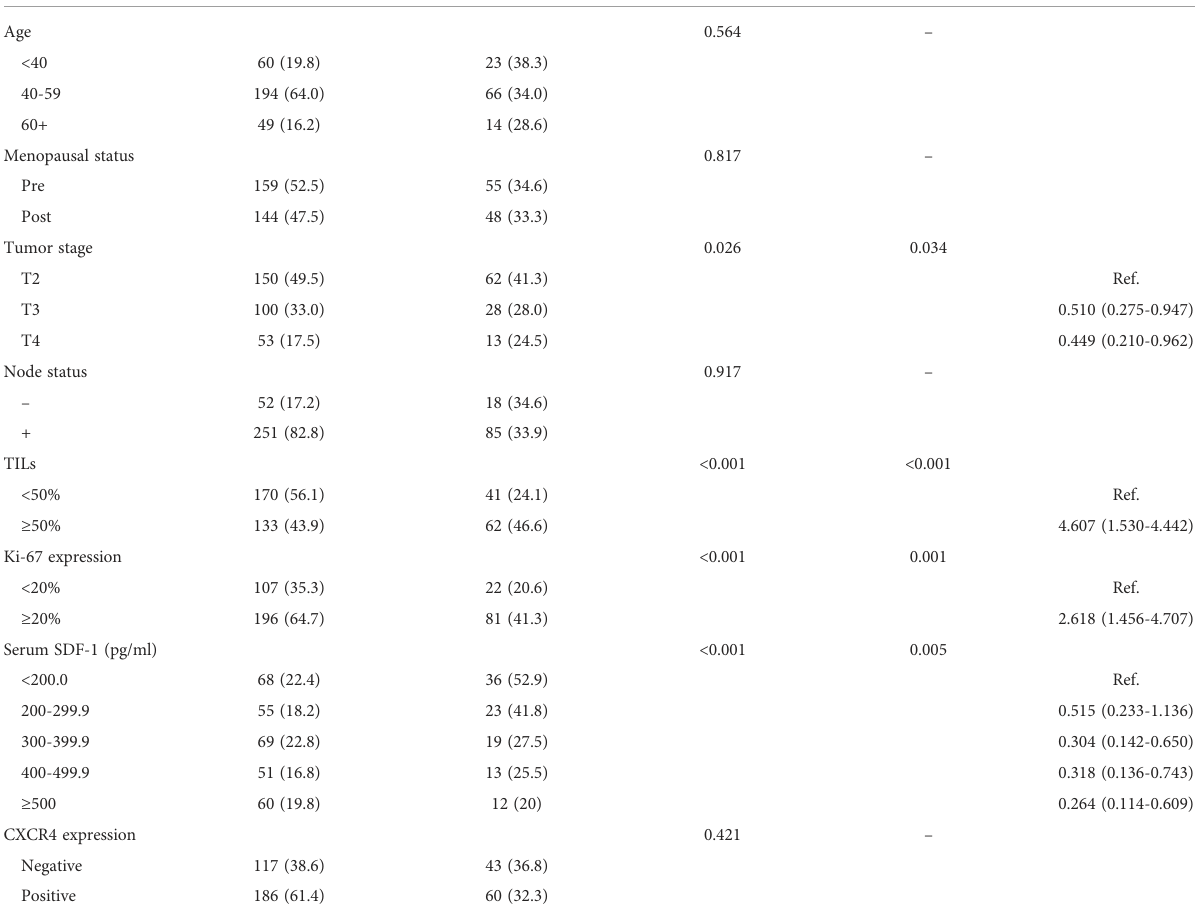
TABLE 1 Patient characteristics and observed pathological complete response (pCR).